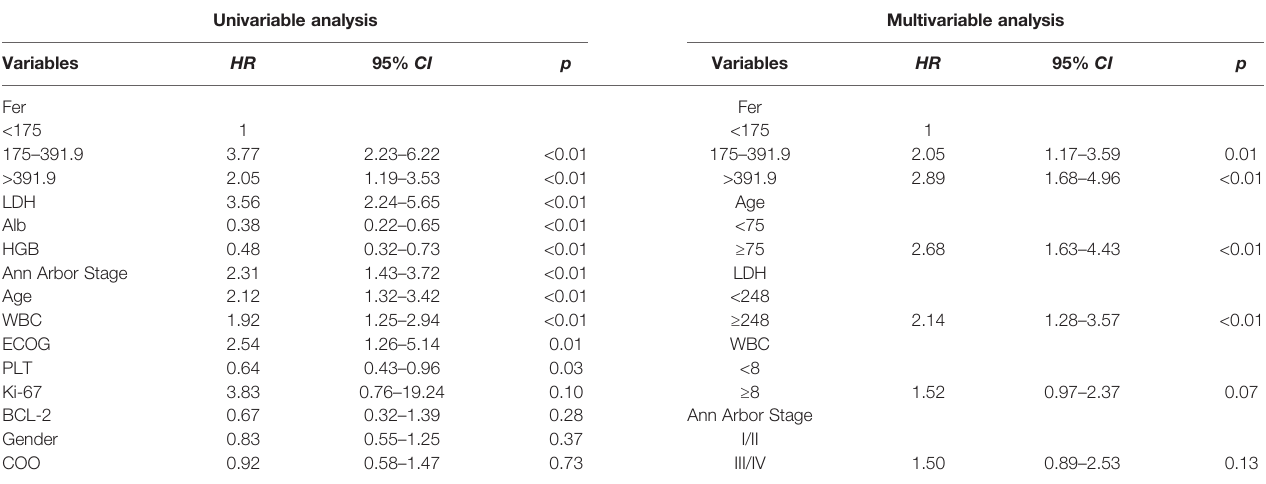
TABLE 2 | Prognostic factors of OS in the derivation